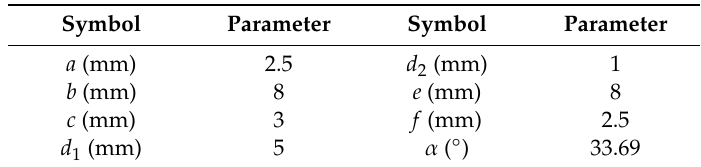
Figure 1. Structure of the hourglass shaped wireless and passive magnetoelastic sensor (HSMS). Table 2. Dimensions of the HSMS.